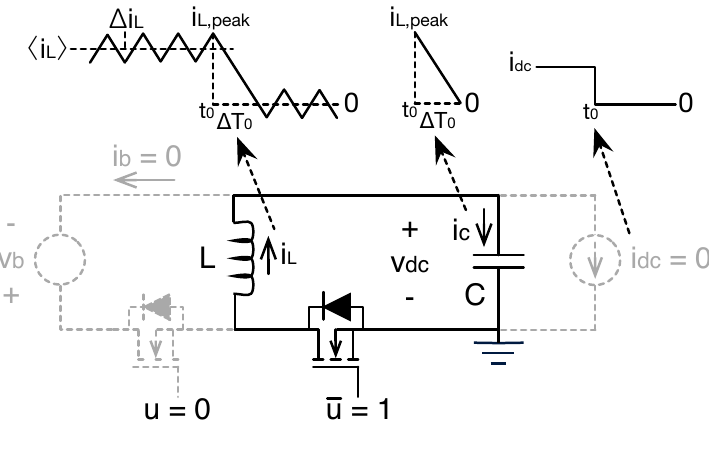
Figure 7. Current waveforms due to a 100% step-down DC-bus current